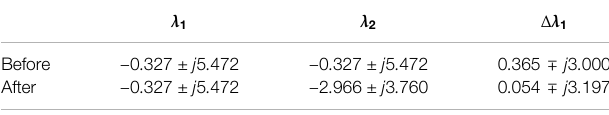
TABLE 4 | Calculation results before and after parameter adjustments.